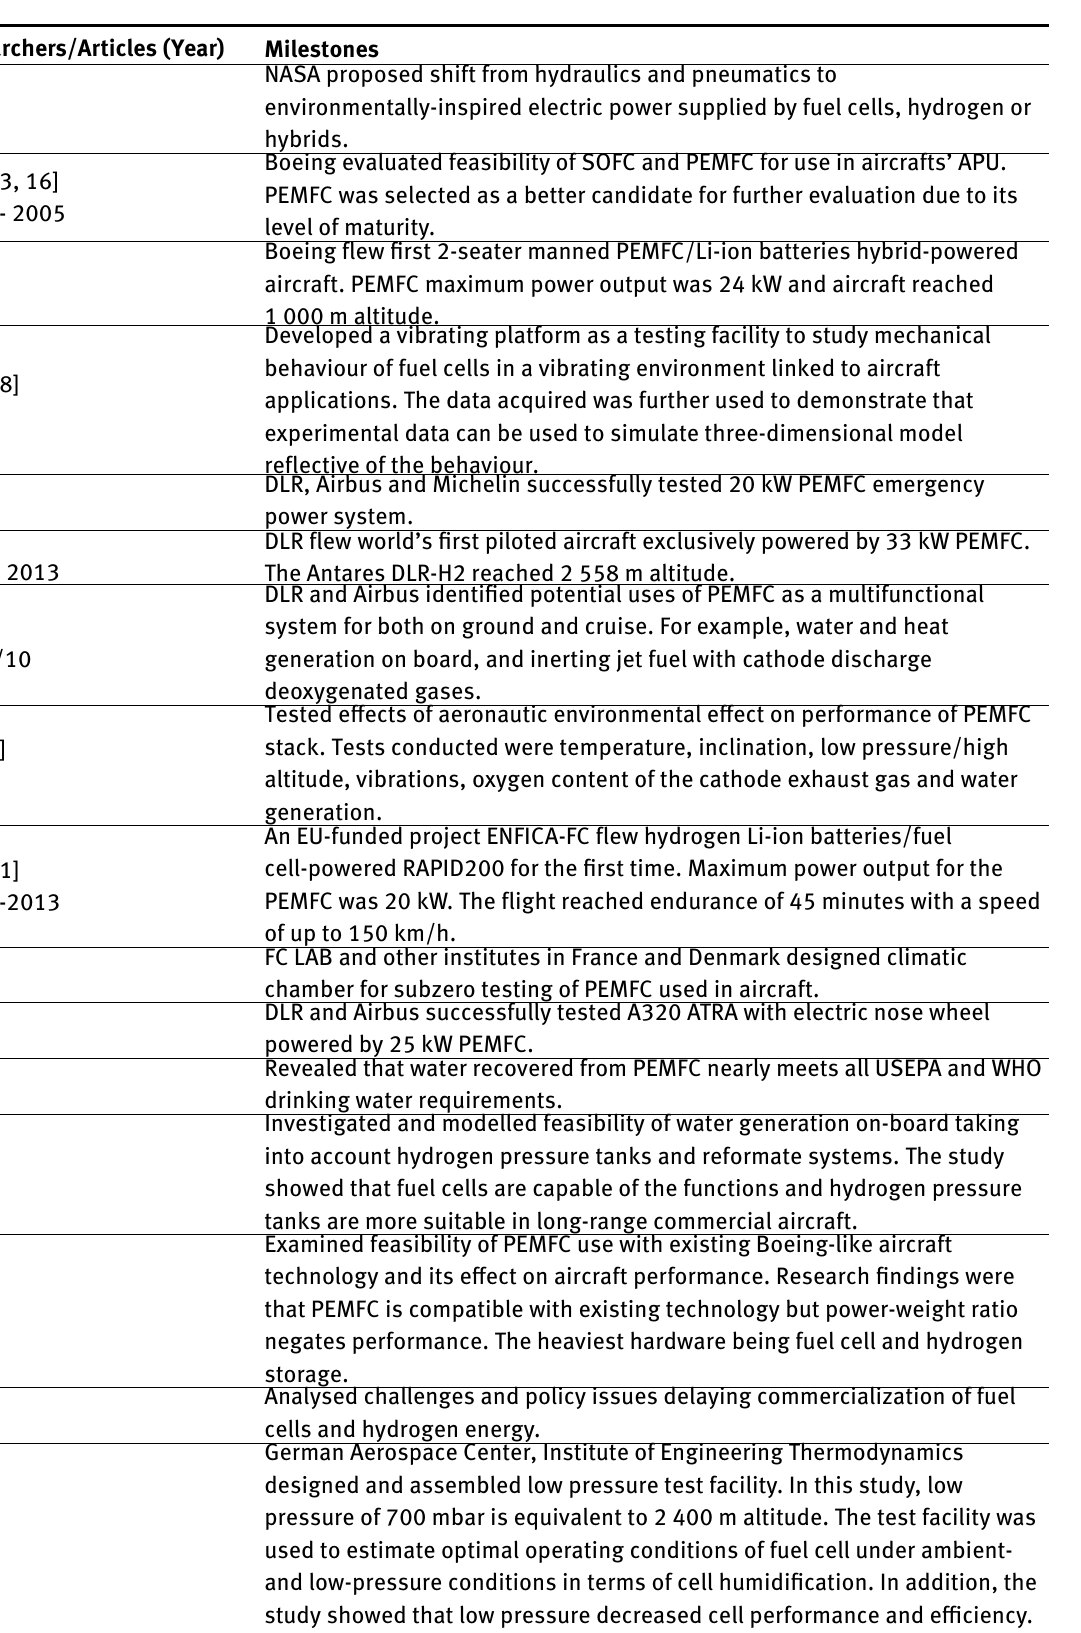
Table 1: Highlights of PEMFC applications in aircraft Researchers/Articles (Year)